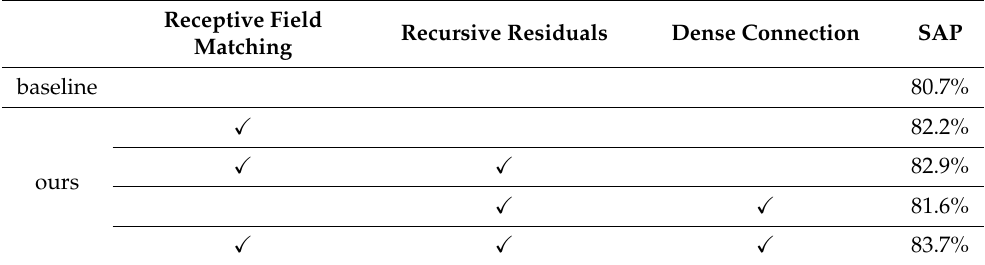
Table 3. Evaluation results of the feature super-resolution